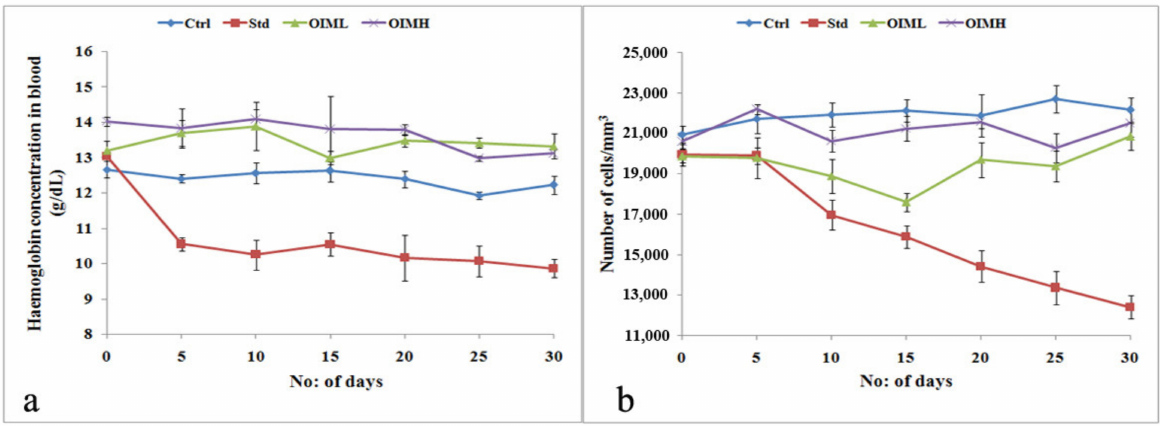
Figure 5. Comparison of hematological parameters between cyclophosphamide-treated animals and the other study groups during solid tumor induction. ( a ) Percentage hemoglobin (g/dL) and ( b ) total leucocyte count (no: of cells/mm 3 ) of Ctrl—tumor-induced group, having received no treatment; Std—cyclophosphamide (i.p.) treated group at dosage 10 mg/kg b.wt; OIML—low-dose group treated with OIM at dosage 200 mg/kg b.wt., and OIMH—high-dose group treated with OIM at dosage 400 mg/kg